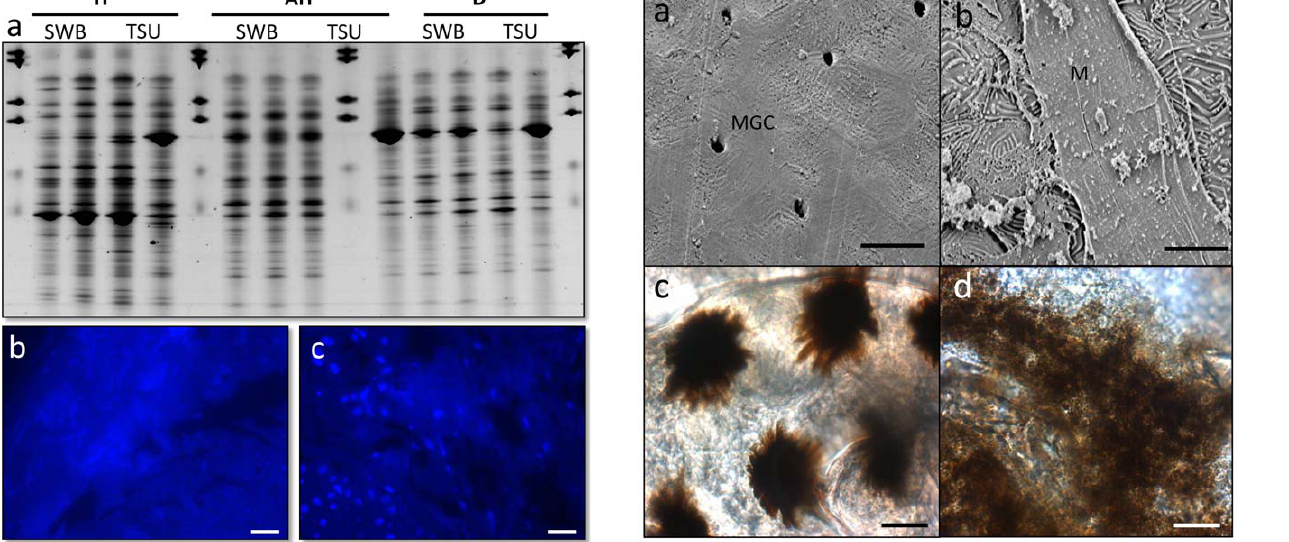
Figure 2. Microbial analysis of Plectropomusleopardus samples; a) Bacterial 16S rRNA gene fingerprints (represented on Denaturing Gradient Gel Electrophoresis) of fish mucus (SWB) and tissue samples (TSU), standardised for gel-to-gel comparison using BioNumerics; b) resin embed histological section of a healthy fish, stained with the general DNA stain 4 9 6-diamidino-2-phenylindole (DAPI); c) histological section of the lesion on a diseased fish stained with DAPI, both showing no bacteria within the dermis suggesting the bacteria present in (a) are localised within the mucus layer not within the tissues. Scale bars=10 m m.